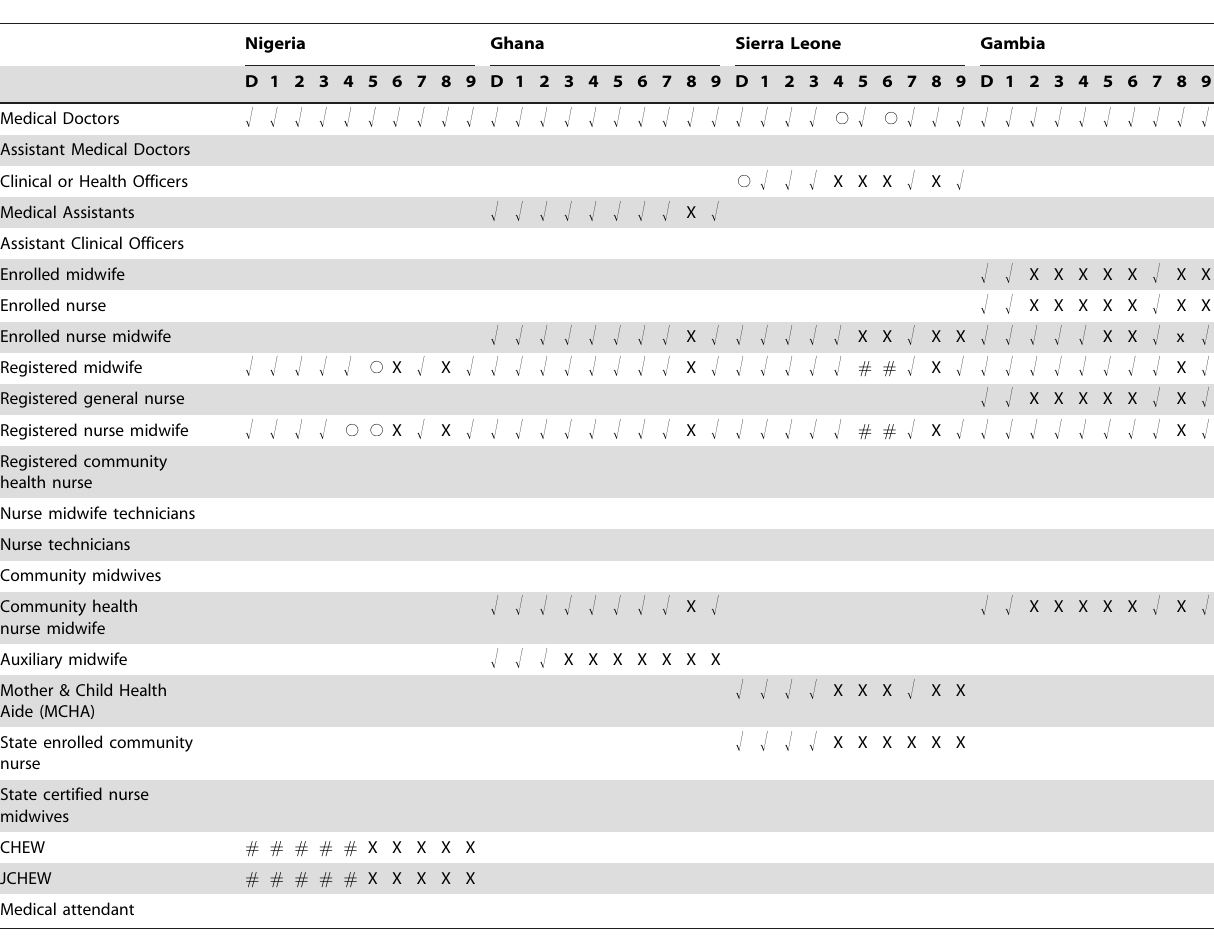
Table 5. Signal functions reported to be performed by different cadres of clinicians (Western